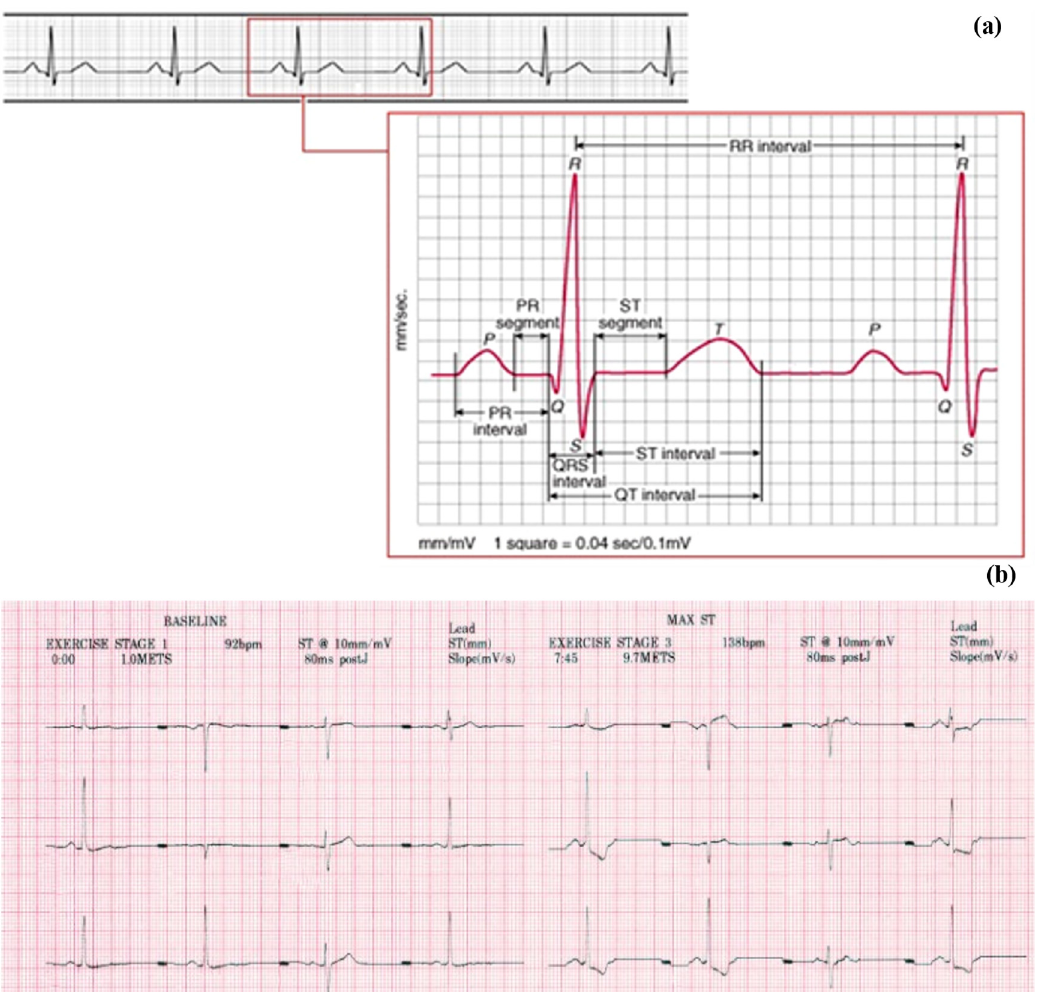
(Figure 1b). Coronary artery disease (CAD) pertains to constriction or blocking of the coro- nary arteries caused by plaque formation. There are few literature studies related to CAD due to the lack of data and its complexity [10]. CAD is commonly identified and diagnosed based on different tests, such as ECG, treadmill ECG, echocardiogram (ECHO), and angiog- raphy. The intelligent systems use different neural architectures, such as the convolutional neural network CNN [11], recurrent neural network (RNN) [12], CNN with RNN [13,14], deep belief network (DBN) [3,15], and the fully-connected neural network (FC) [11] to predict electrocardiogram (ECG)-related issues, such as arrhythmia [16–20], atrial fibril- lation (AF) [21–23], myocardial infarction (MI) [24,25], ST elevation [21], CAD [10,26–28], etc. Tan, J.H.; Hagiwara, Y. et al. [10] implemented a long short-term memory (LSTM) network with the convolutional neural network (CNN) to automatically diagnose CAD based on ECG signals. Babao˘glu, ˙Ismail, and Findik et al. [26] compared various feature selection models utilizing binary particle swarm optimization and a genetic algorithm using a support vector machine classifier. Kumar, Mohit, and Pachori et al. [27] worked on limited repository data using the wavelet transform method for a CAD-related diagnosis. Kurt, I., Ture, M. et al. [28] carried out a comparative study on various types of classifiers related to CAD.